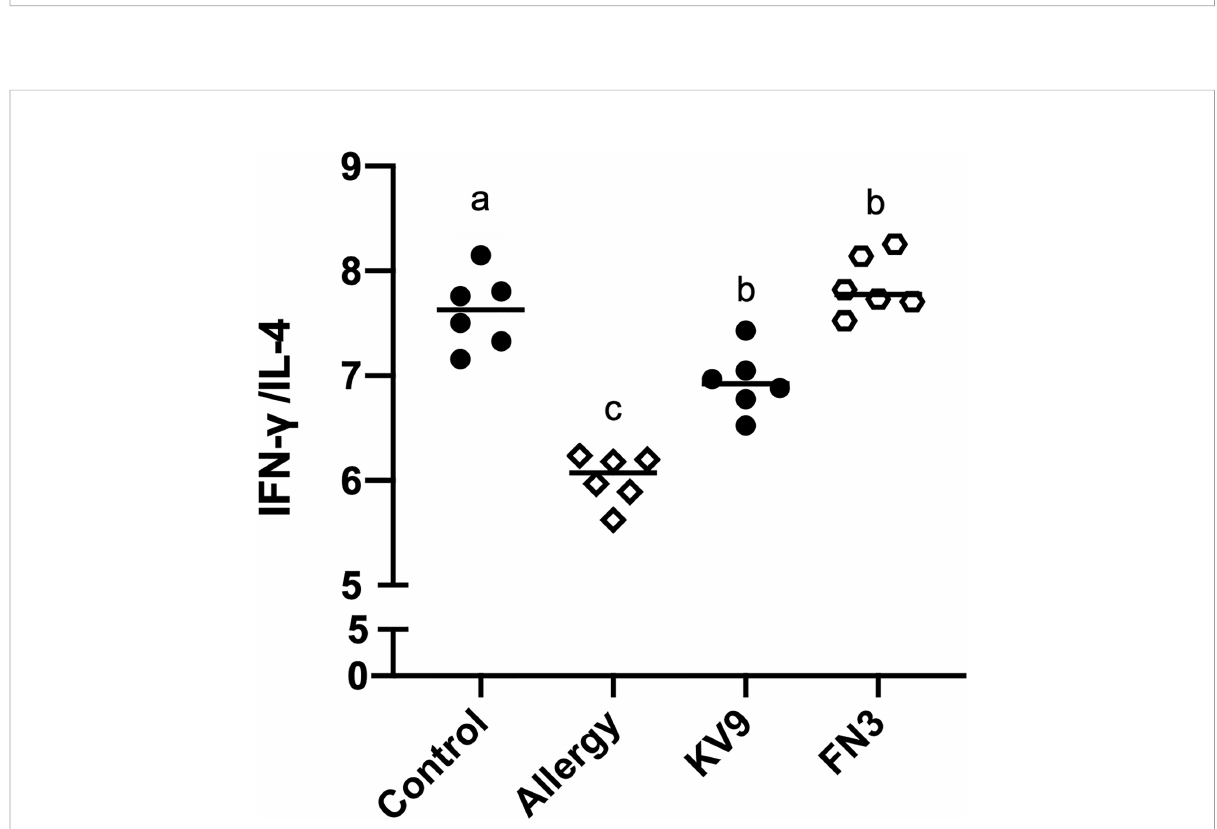
FIGURE 8 The ratio of IFN- g (pg/ml)/IL-4 (pg/ml) cytokine levels secreted from spleen lymphocytes. Identical lowercase in the fi gure indicates the lack of signi fi cance ( p <